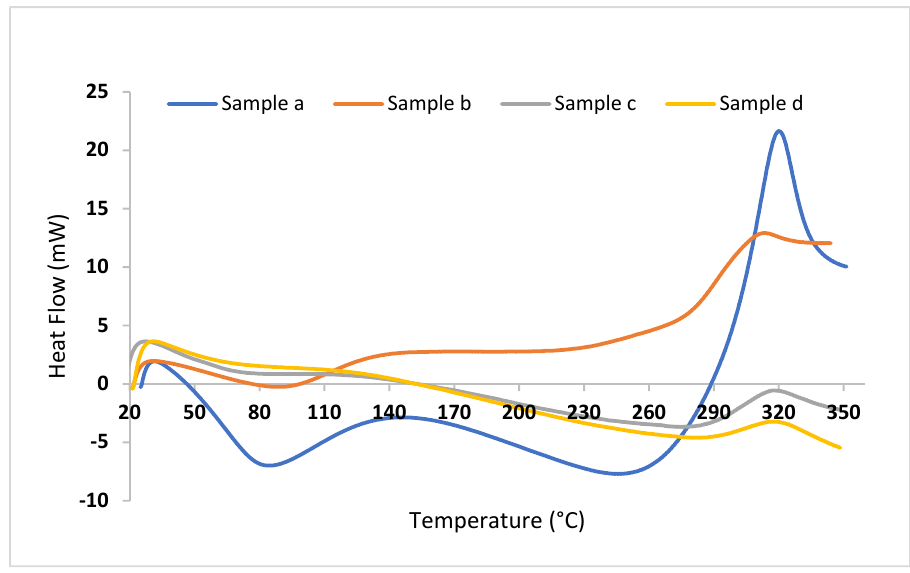
Figure 3. Differential scanning calorimetry of tested films: ( a ) Chitosan; ( b ) Chitosan + 0.1%GEO; ( c ) Chitosan + 0.2% GEO; ( d ) Chitosan + 0.3% GEO.